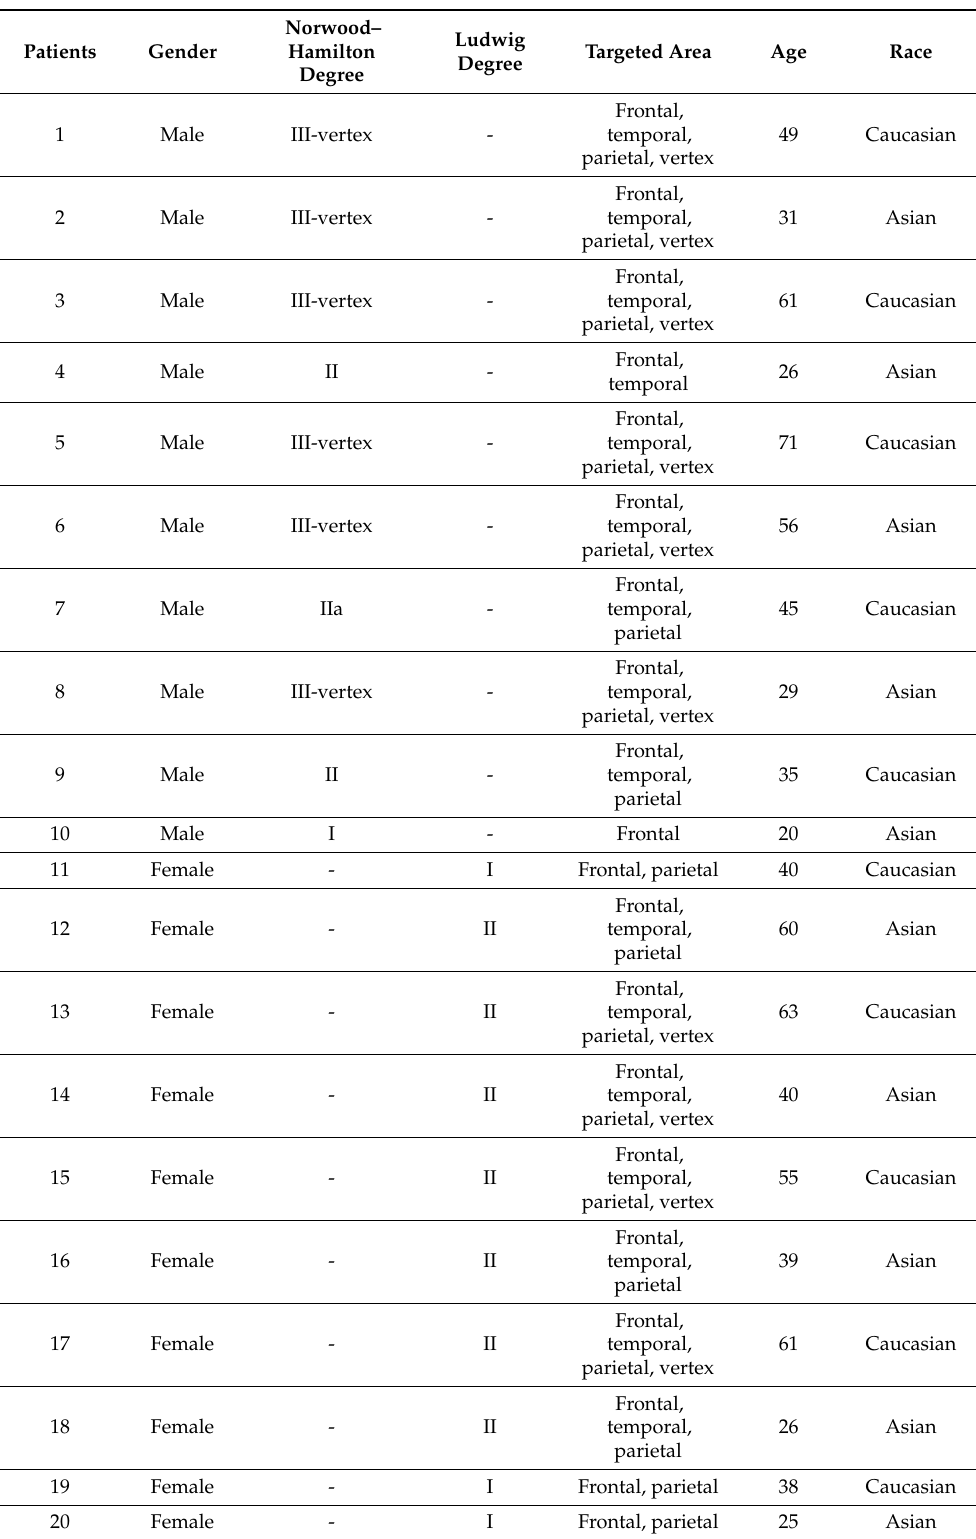
Table 1. Patient